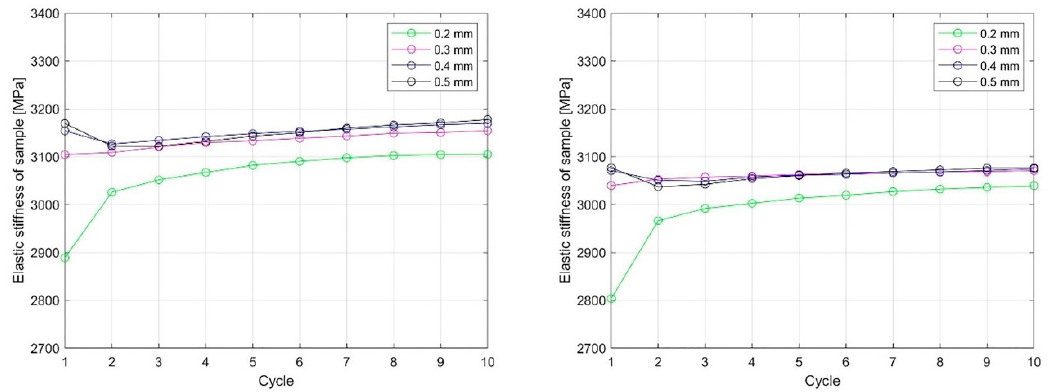
Figure 20. The dependency of the ES of the sample on the number of cycles and the loading path for 1.6 mm (left) and 2.4 mm (right) ILD (initial nominal displacement 0.2 mm).